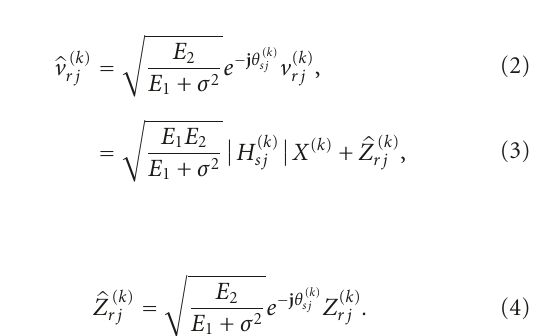
Figure 2: AF/DF transmission protocol in a cooperative SFBC- OFDM